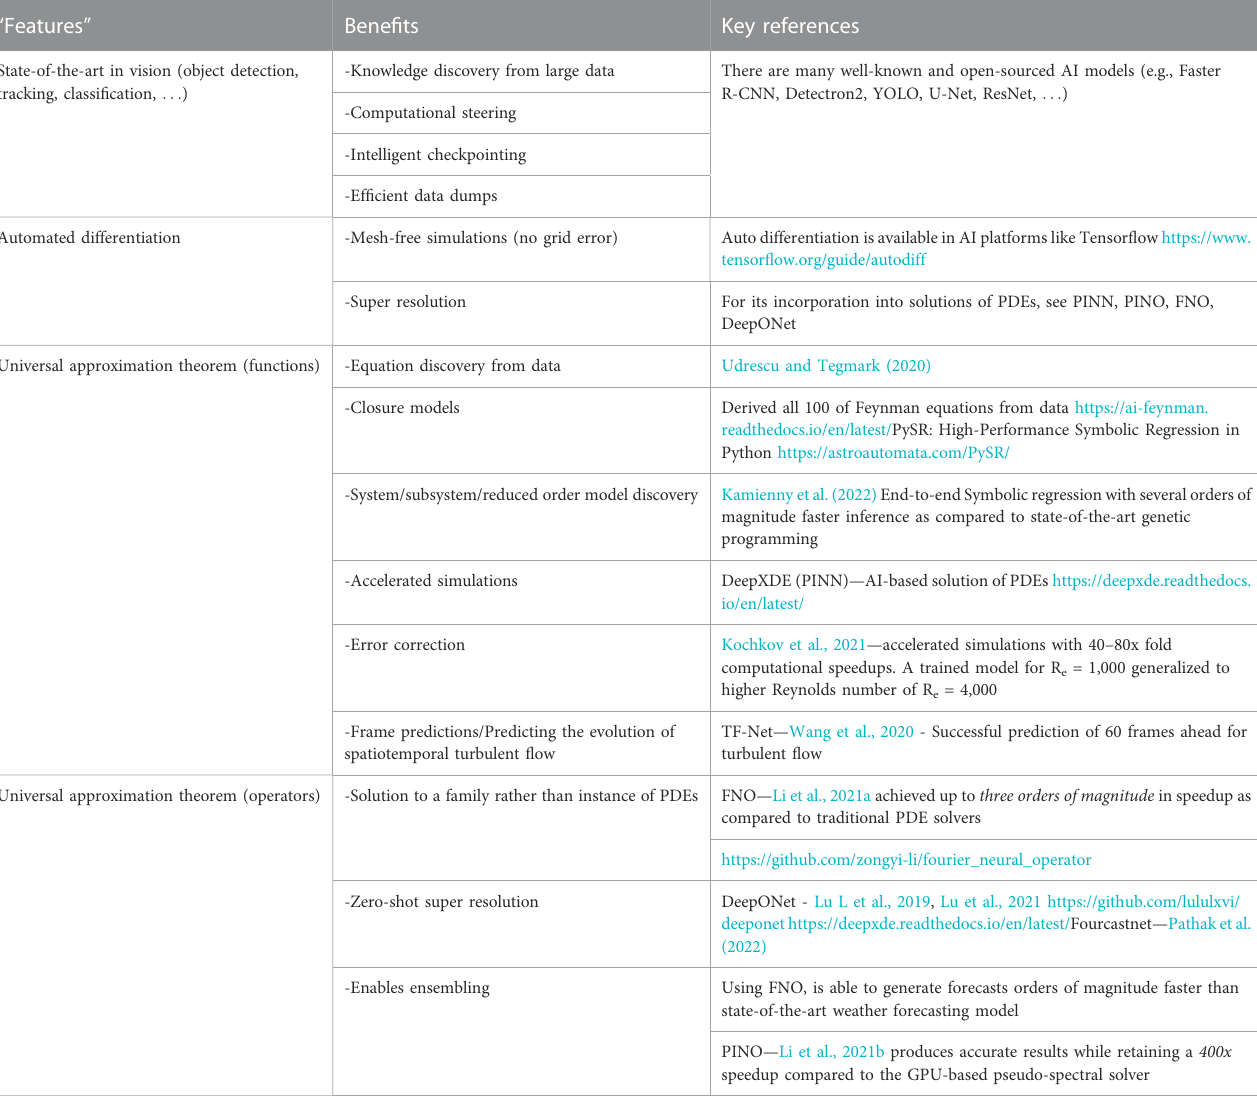
TABLE 1 Summary of key features of ANNs that enable new capabilities in HPC. References to some recent work that have gone beyond the proof of concept stage are also provided. “ Features